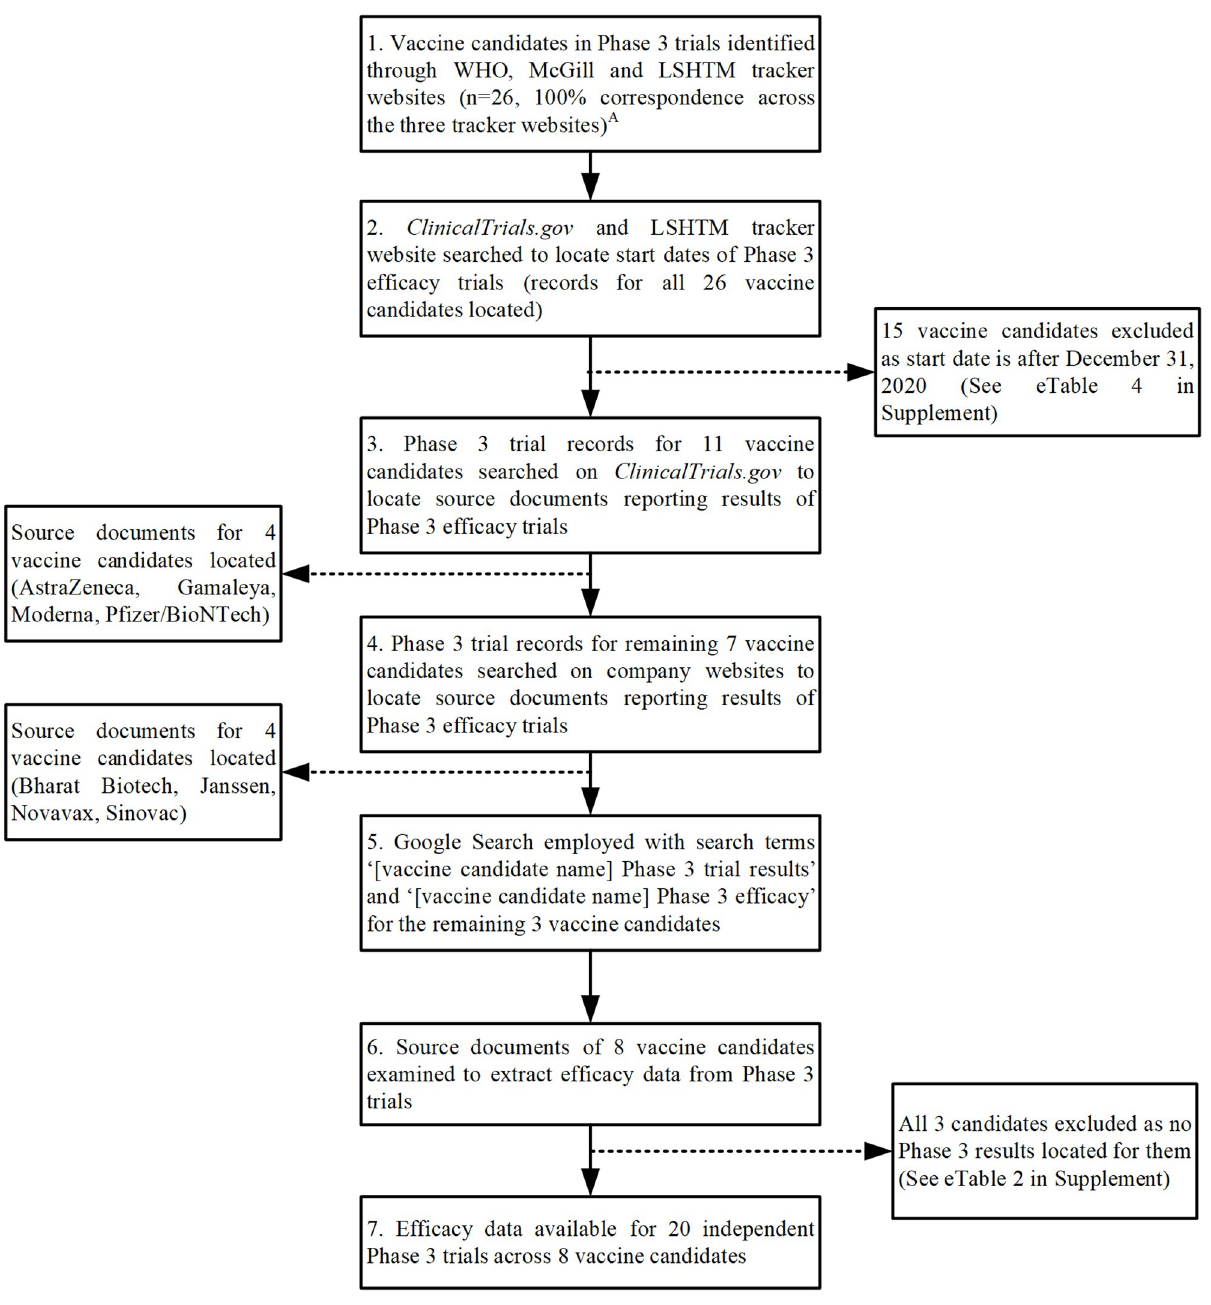
Fig 1. Study selection. This shows the step-wise process of study selection and pre-specified inclusion and exclusion criteria.